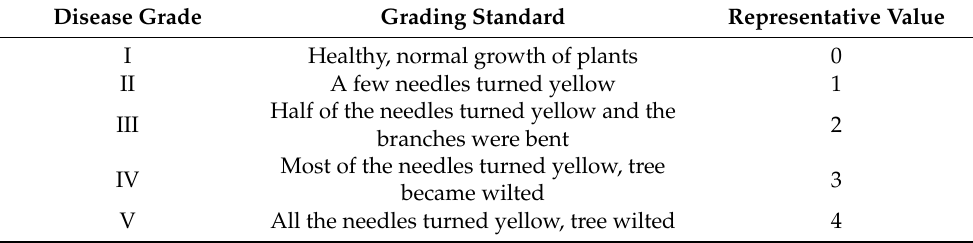
Table 1. Disease grade of pine wilt disease in P. massoniana and L . kaempferi . Disease Grade Grading